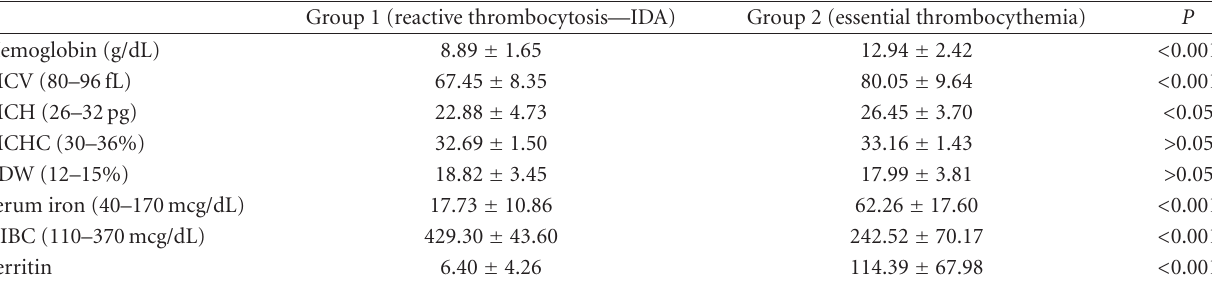
Table 2: Comparison of hemoglobin, red blood cell indices, and serum iron profile.